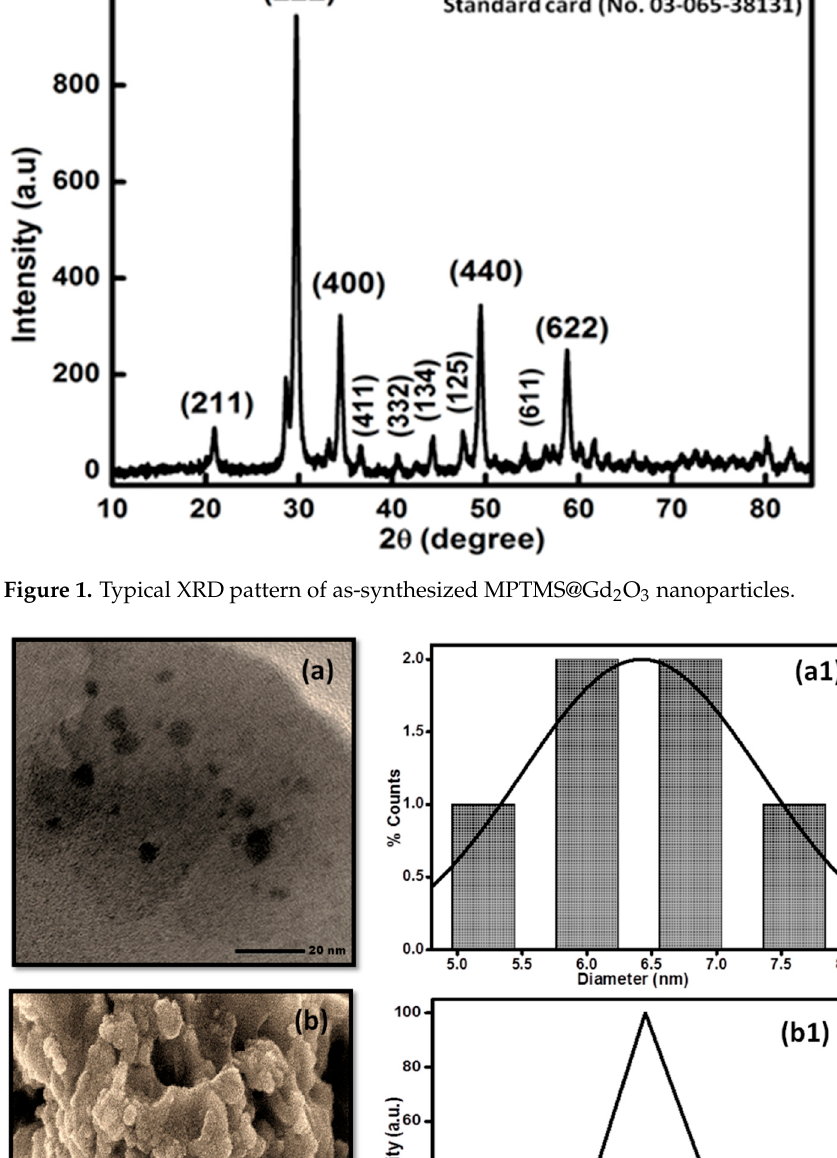
Figure 2. Typical ( a ) TEM image, ( a1 ) Size distribution plot, ( b ) SEM image, and ( b1 ) hydrodynamic diameter of MPTMS@Gd 2 O 3 nanoparticles.